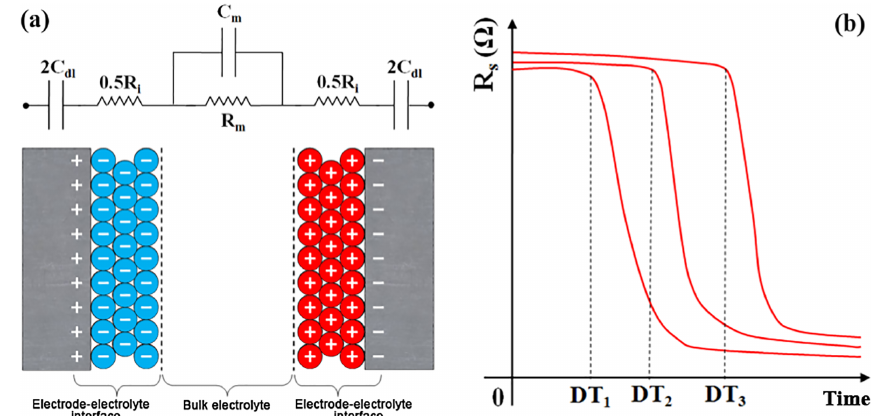
Figure 2. (a) Equivalent electrical circuit for two electrodes immersed in liquid electrolyte; (b) measured electrical resistance versus time during bacterial